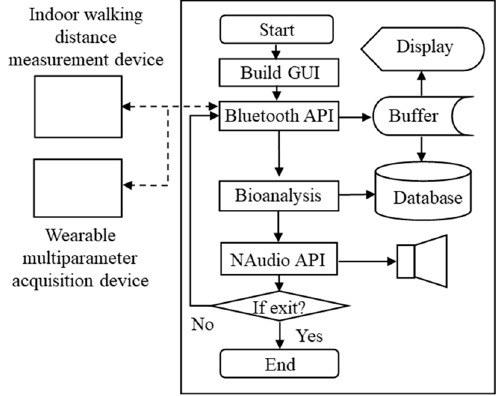
Figure 5. Flowchart of the multiparameter monitoring program.